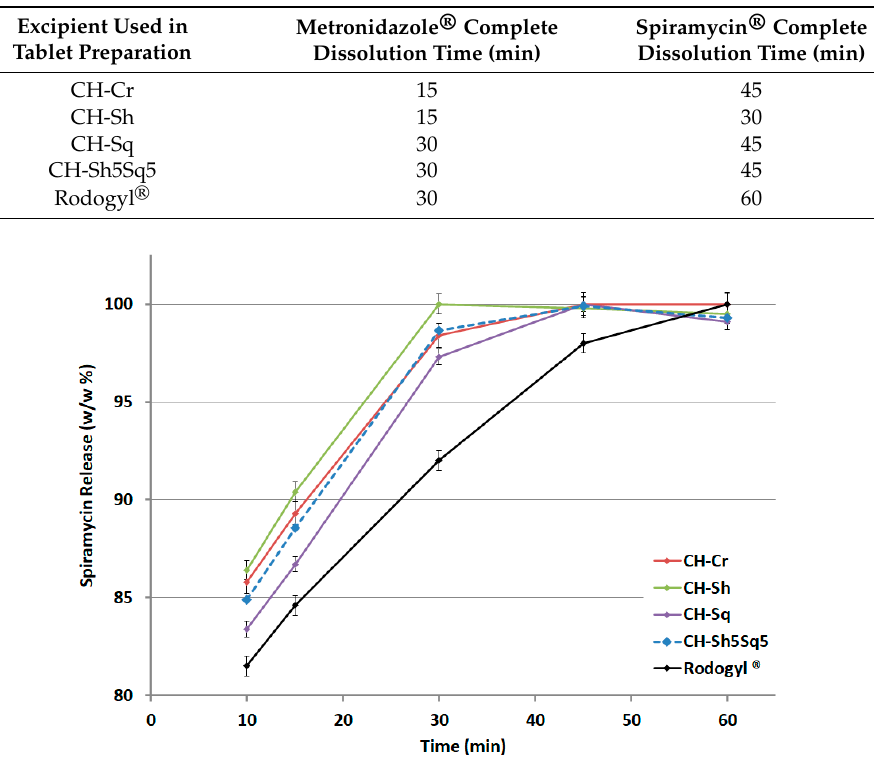
Figure 12. Dissolution profile for metronidazole (200 mg) tablets comprising compacted CHs or CH mixture (CH-Sh5Sq5) compared to Rodogyl ® tablets.